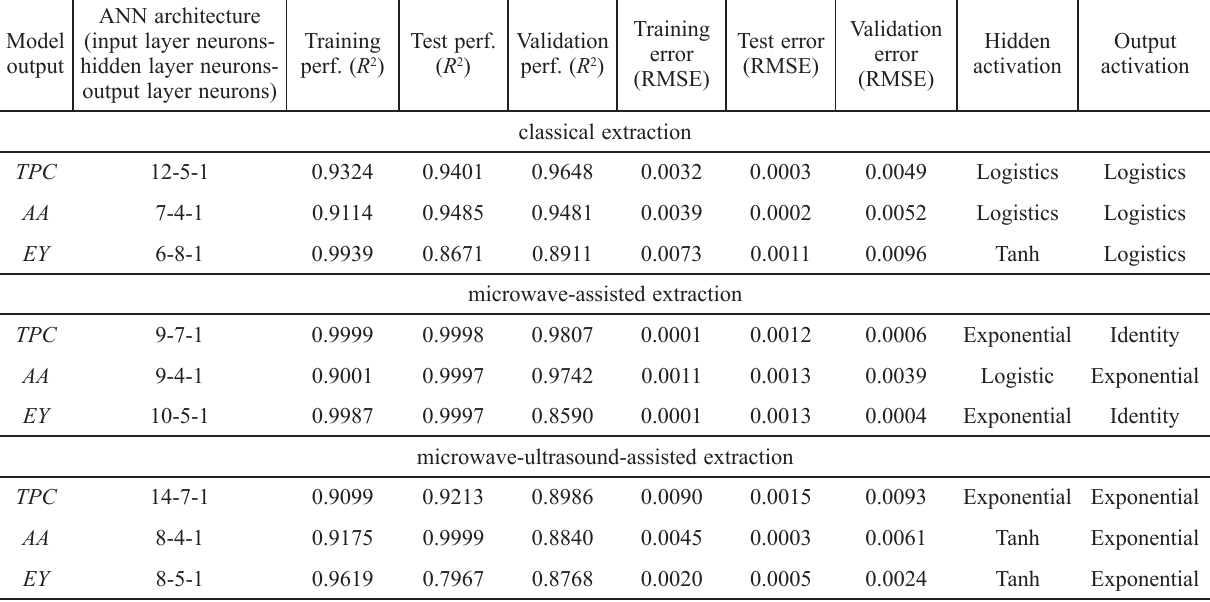
Table 3 – Characteristics and performance of the ANN models developed for the prediction of polyphenols, antioxidant activity, and extraction yield of olive leaf aqueous extracts prepared by conventional extraction, microwave-assisted extraction, and microwave- ultrasound-assisted extraction Model